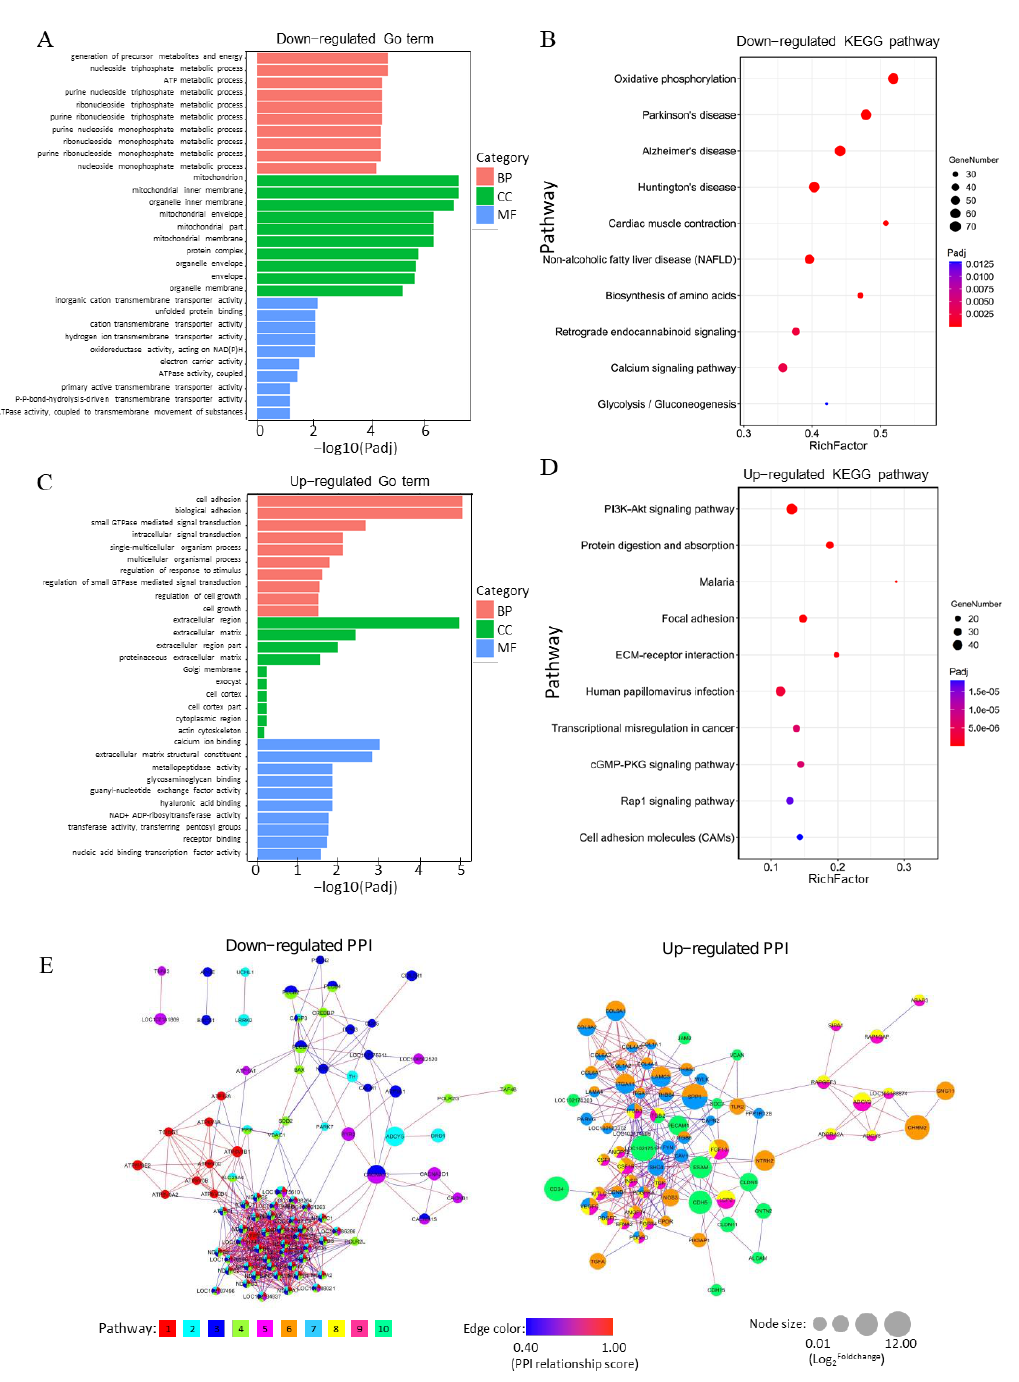
Figure 4. Functional categorization and signaling pathways enrichment of two-cluster DEGs by GO and KEGG classification in trophoblasts at early pregnancy. ( A ). GO functional classification of down-regulated DEGs. BP, biological process; MF, molecular function; CC, cellular component. ( B ). KEGG pathway enrichment analysis of down-regulated DEGs. ( C ). GO functional classification of up-regulated DEGs. BP, biological process; MF, molecular function; CC, cellular component. ( D ). KEGG pathway enrichment analysis of up-regulated DEGs. ( E ). Protein-protein interaction (PPI) analysis of two-cluster DEGs at three early pregnancy stages. Left side, down-regulated DGEs. The right site indicates up-regulated DGEs. Pathway: 1, Oxidative phosphorylation. 2, Parkinson’s disease. 3, Alzheimer’s disease. 4, Huntington’s disease. 5, Cardiac muscle contraction. 6, PI3K-Akt signaling pathway. 7, Focal adhesion. 8, ECM-receptor interaction. 9, Rap1 signaling pathway. 10, Cell adhesion molecules